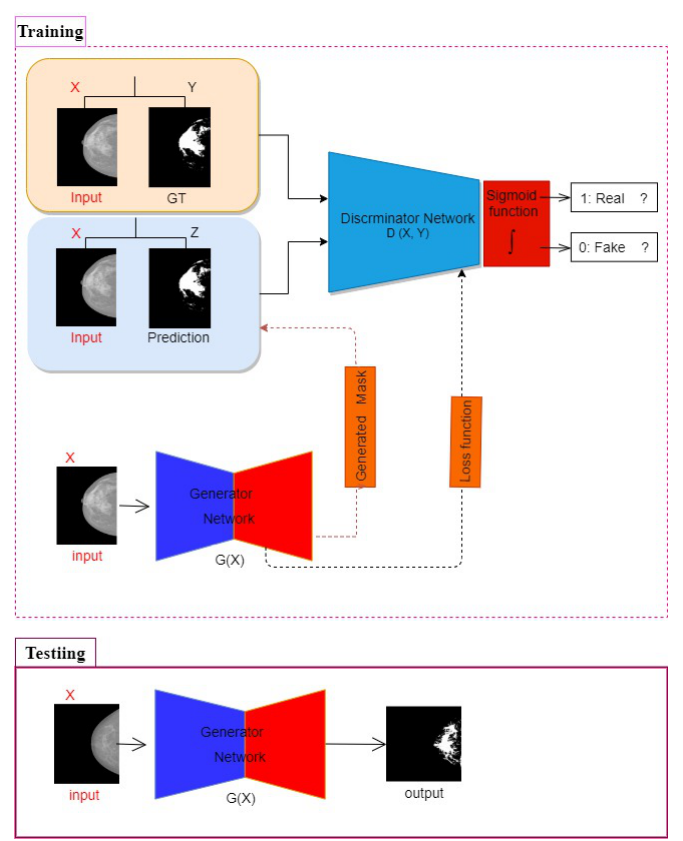
Figure 4. cGAN framework for